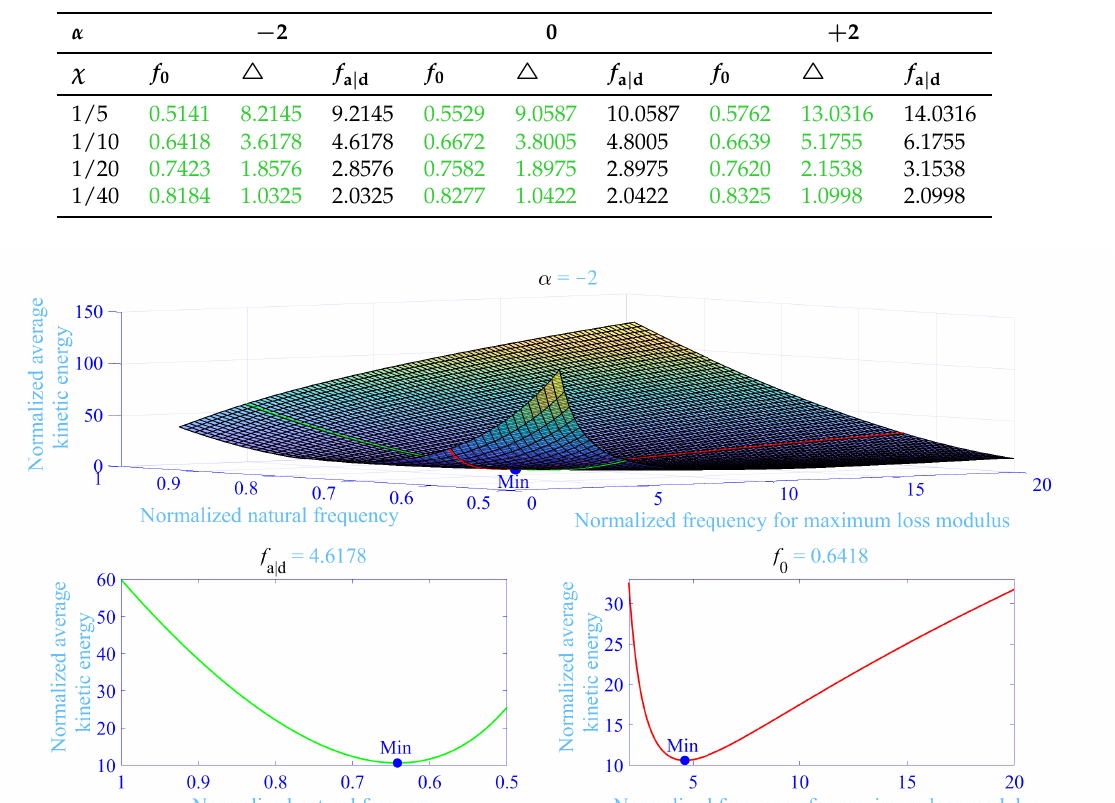
Figure 3. Frequency averaged normalized kinetic energy of the primary vibration system M versus the normalized natural frequency for dynamic vibration absorber and versus the normalized frequency for maximum loss modulus, with C = 0.04 and χ = 1/10. The global minimum of the frequency averaged maximum normalized kinetic energy [Min] is shown with a blue bullet ( • ) being located at the crossing between the green and red